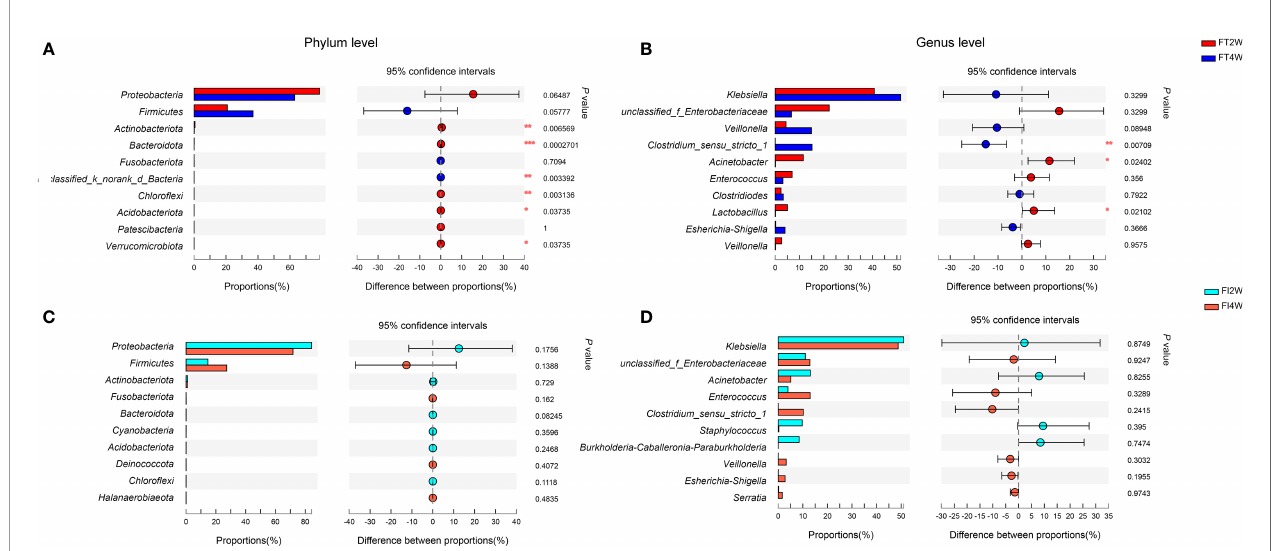
FIGURE 4 | Community abundance within groups. In the FT group, the abundances of Actinobacteria , Bacteroides and Chloro fl exi at the phylum level (A) and Clostridium at the genus level (B) were higher at 4 weeks than at 2 weeks of life. The community abundance at the phylum level (C) or at the genus level (D) was not different between 2 and 4 weeks after birth in the FI